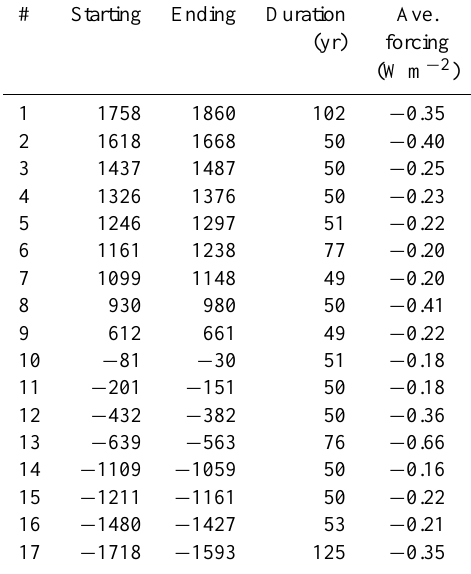
Table 1. Seventeen periods of strong volcanic events at a multi- decadal scale over the past 4000yr. Positive and negative years indicate CE and BCE, respectively. Average forcing has a unit of Wm − 2 . Note that the dates were calculated from smoothed vol- canic forcing such that a comparison with proxy records is effective only for multidecadal or longer